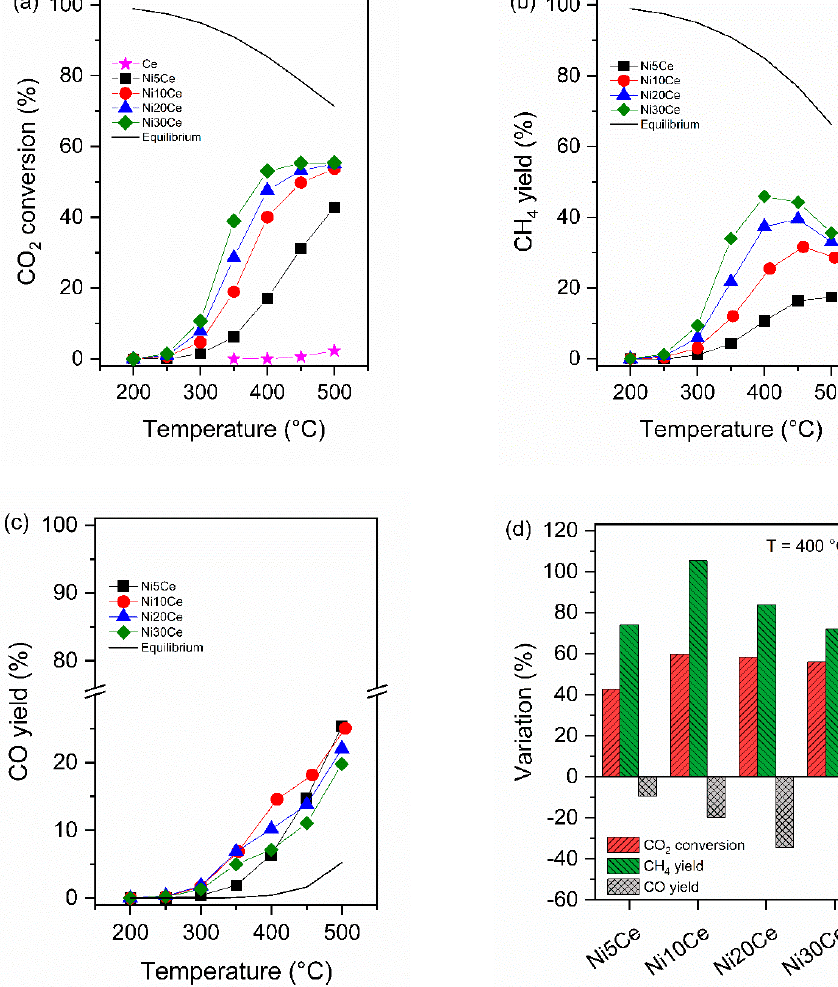
Figure 5. Catalytic activity: CO 2 conversion ( a ), CH 4 yield ( b ) and CO yield ( c ) as a function of temperature; reaction conditions: reactant mixture CO 2 :H 2 :N 2 :He = 1:4:2:13, catalyst mass = 40 mg, gas hourly space velocity (GHSV) = 300 L g − 1 h − 1 . Percentage variation of the CO 2 conversion, CH 4 yield and CO yield, increasing the H 2 / CO 2 ratio from 4 to 8 ( d ): reactant mixture CO 2 :H 2 :N 2 :He = 1:8:2:9, catalyst mass = 40 mg, GHSV = 300 L g − 1 h − 1 .